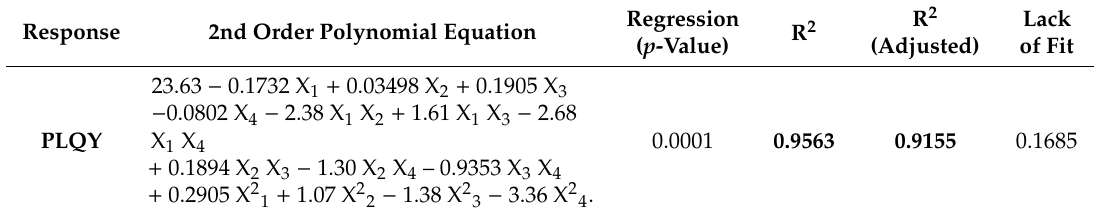
Table 3. The fitted quadratic model in terms of coded